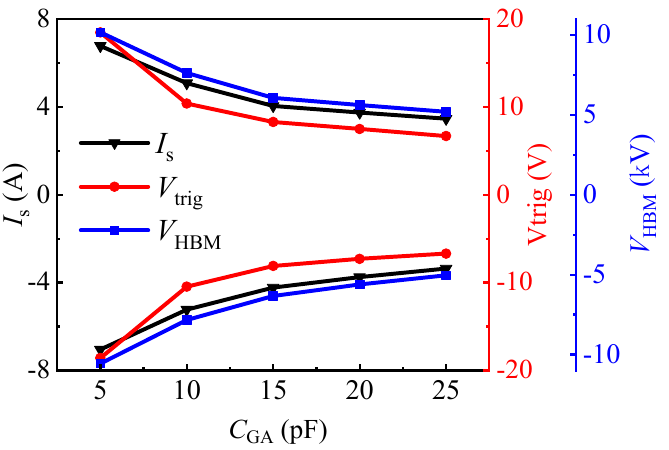
Figure 7. I S , V trig and V HBM of the proposed AlGaN/GaN B-ESD-PD with C GA ( C GC ) increasing from 5 pF to 25 pF.